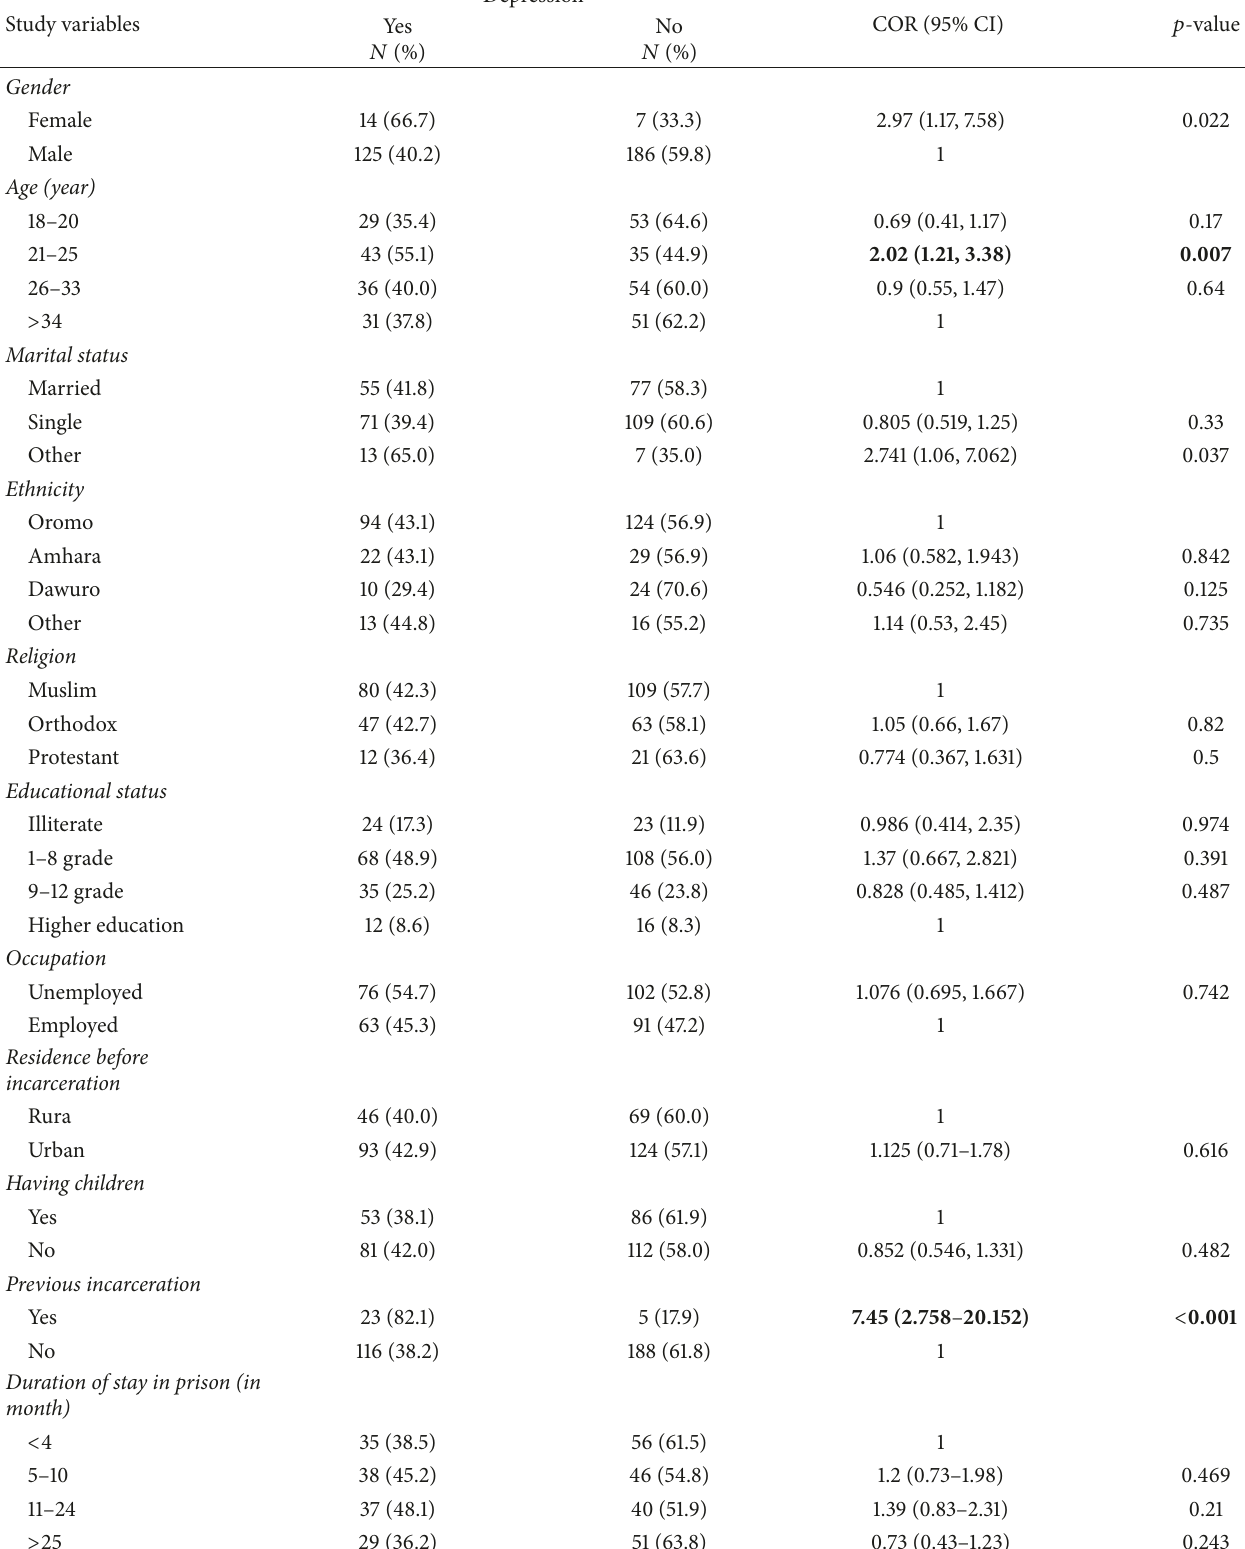
Table 3: Factors associated with depression by bivariate logistic regression among prisoners in Jimma town prison, South West Ethiopia, June 2017 ( 𝑁 = 332